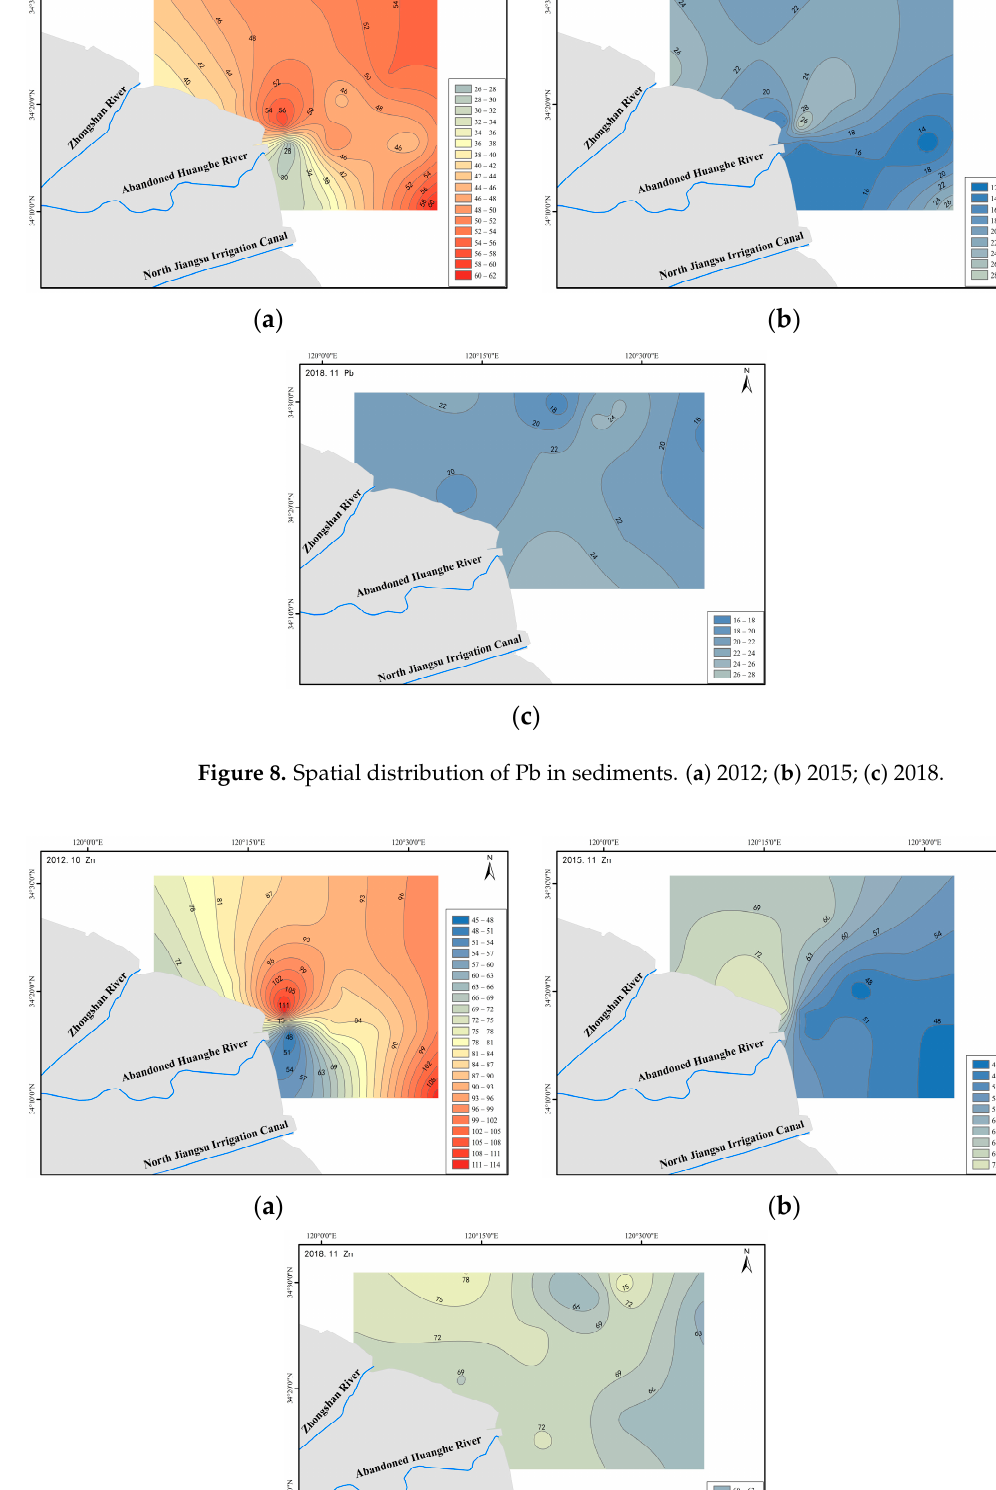
Figure 9. Spatial distribution of Zn in sediments. ( a ) 2012; ( b ) 2015; ( c ) 2018.